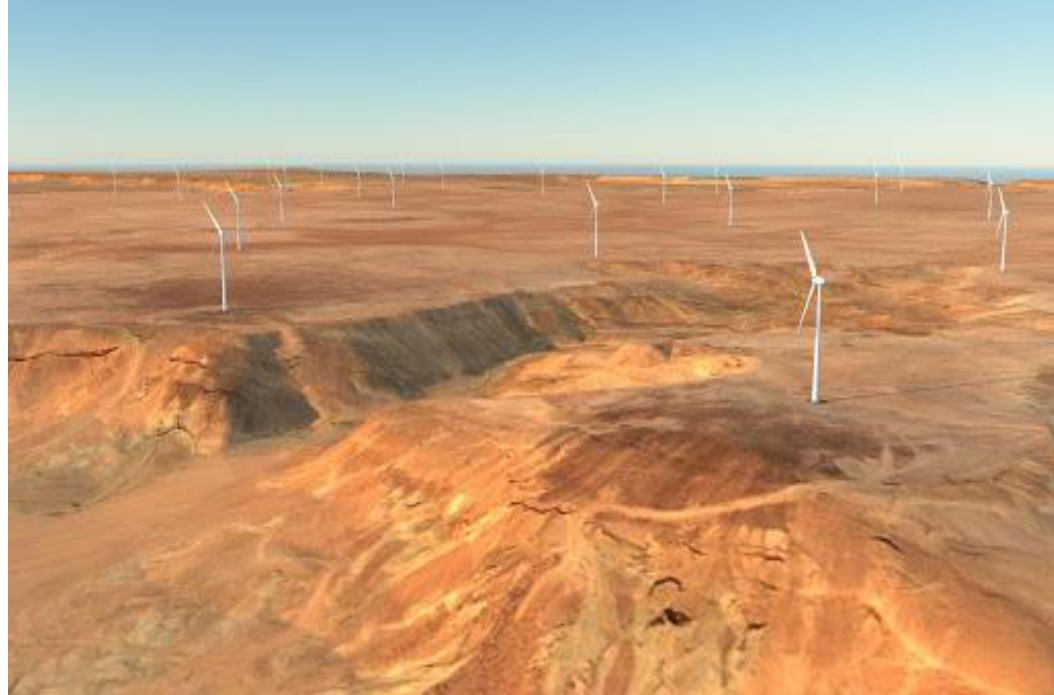
Figure 5. Pictorial description of Dumat Al-Jandal wind farm [22].